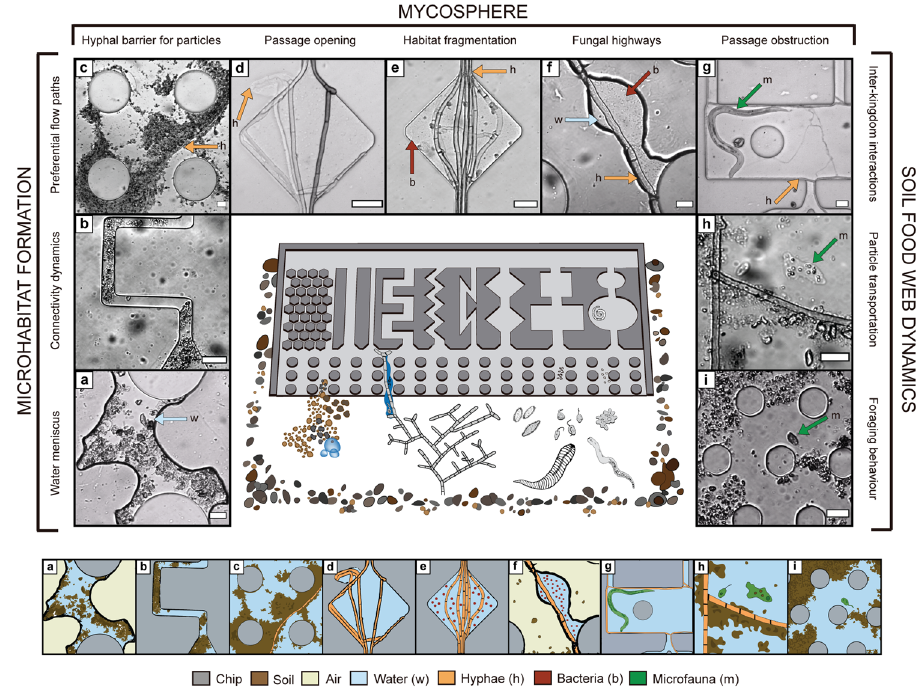
Fig. 1 Soil organisms and processes recorded in micro-engineered soil chips. The chips were colonized in situ from a natural soil when buried in the fi eld. The inner section shows a schematic drawing of the design of the silicone and glass chip (dimensions exaggerated for clarity) and indicates the 7 µ m high opening from where soil components and organisms can enter. Bright- fi eld microscopy images are grouped into the research fi elds of microhabitat formation, the mycosphere, and soil food-web dynamics. A graphic legend below the chip explains content of the microscope images. a Water meniscus connecting soil particles and chip structures. b Mobile soil particles blocking connectivity of the arti fi cial pore spaces. c Preferential water fl ow paths developing among soil particles sedimenting at the bottom of hyphal structures. d Passage opening by hyphae which squeezed through the borders of an arti fi cial pore space, creating a new micropore. e Habitat fragmentation by hyphae clogging a pore neck. f Fungal highways: hypha-facilitated bacterial dispersal across air gaps. g Passage obstruction: a hypha blocking the entrances to a rectangle pore occupied by a nematode. h Particle transport: amoeba transporting ingested bacteria and particles. i Foraging behaviour: fl agellated protozoa foraging around and in soil aggregates. a , d , e Derive from air- fi lled chips; b , f , g , and i derive from malt medium- fi lled chips; c and h derive from water- fi lled chips. Each type of observation was recorded at least 3